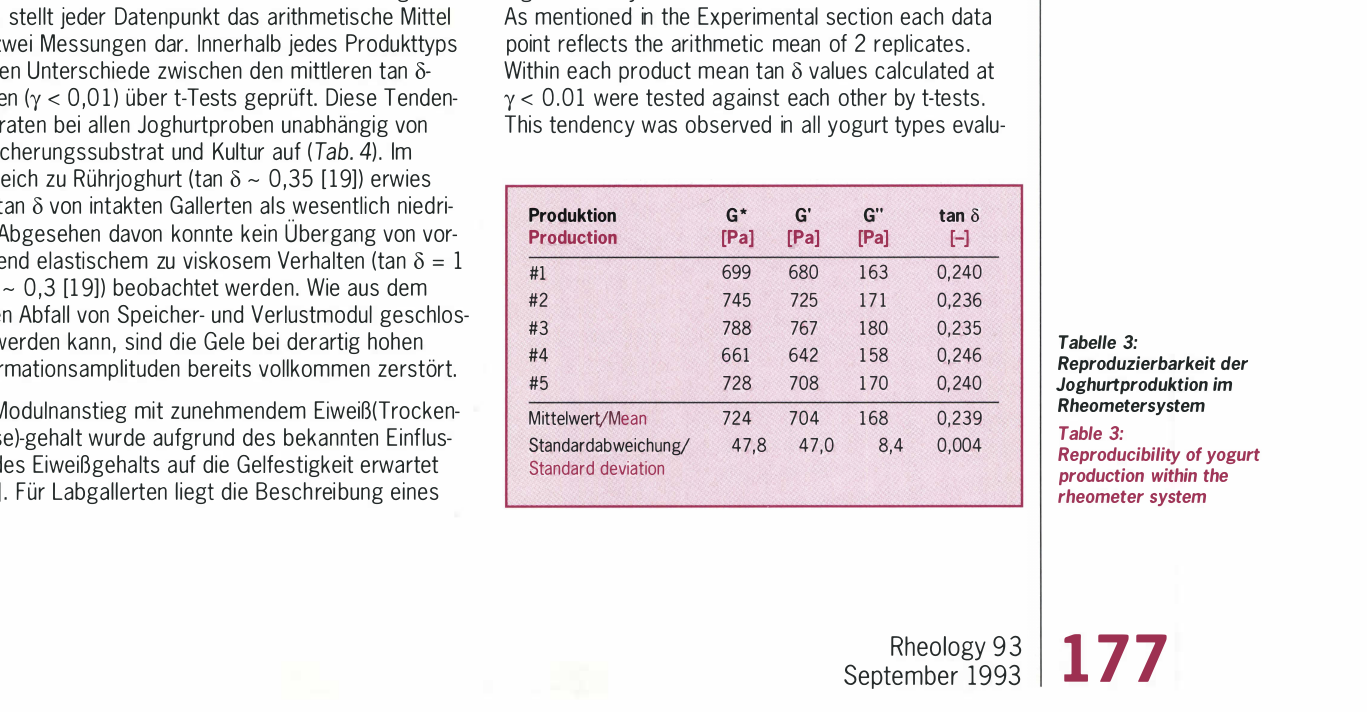
Tabelle 3: Reproduzierbarkeit der Joghurtproduktion im Rheometersystem Table 3: Reproducibility of yogurt production within the rheometer